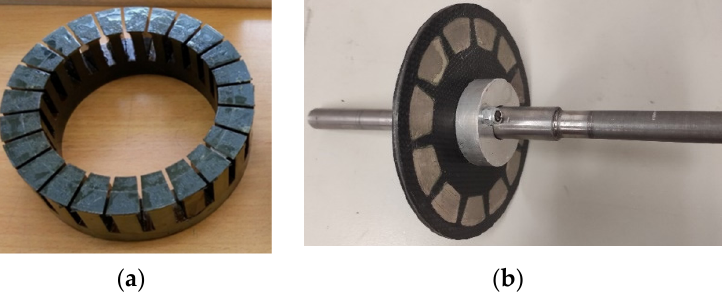
Figure 1. ( a ) Stator post CNC wire cutting; ( b ) Rotor and axle post assembly with PMs.